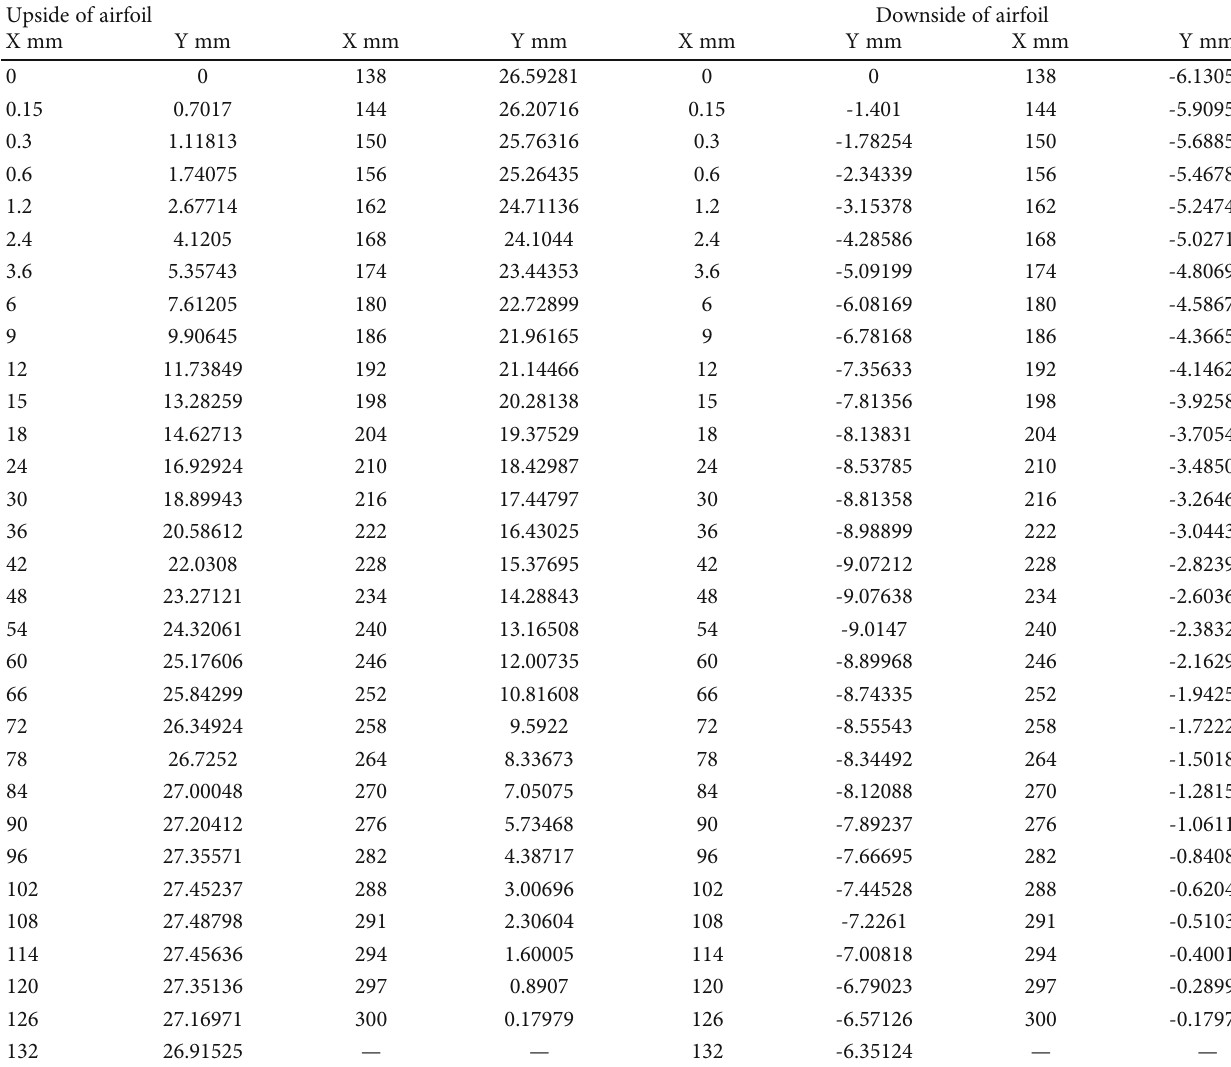
Table 5: Coordinates of Clark Y airfoil.